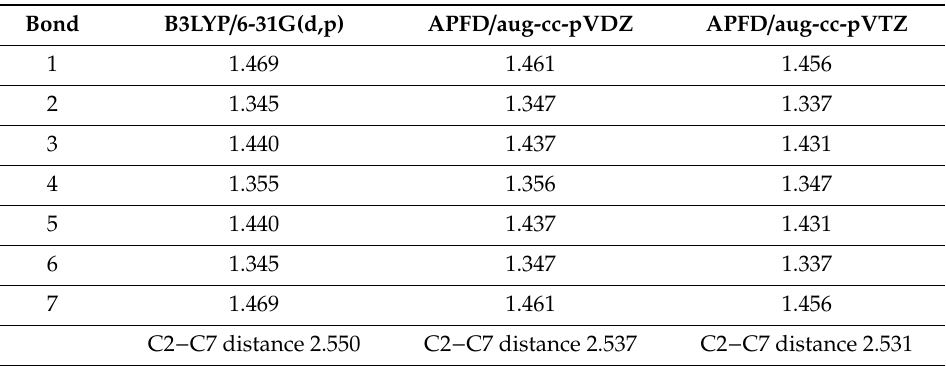
Table 14. Computational structures corresponding to the designated bonds (see Table 13) in the presently unknown N -Methylazepine N -oxide (lowest energy conformation). C − C Bond Lengths in Angstroms for N -Methylazepine N -oxide.